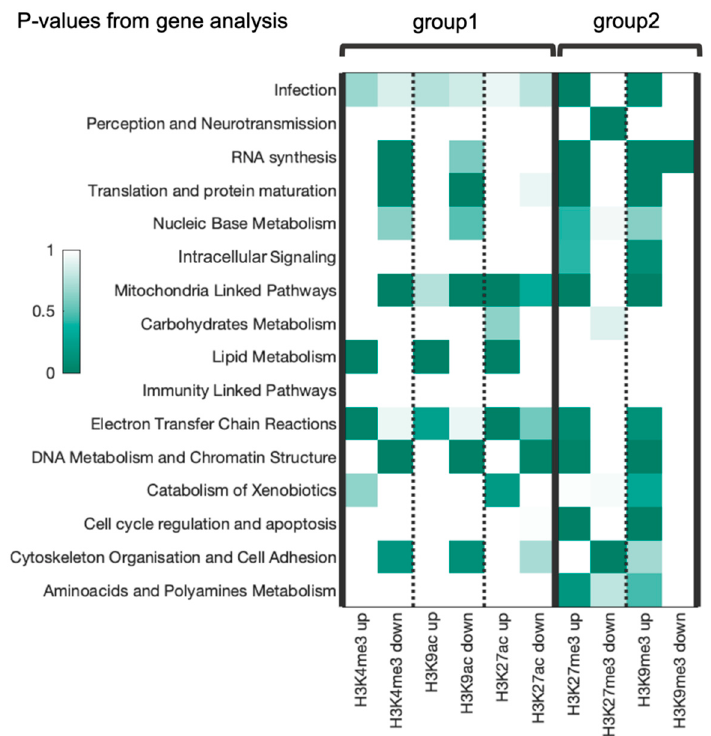
Figure 5. The p -values heatmap for association with regulatory marks linked with REs (RRE) up- or downregulation for each category for each histone tag. Up/down means enrichment/deficiency, respectively.